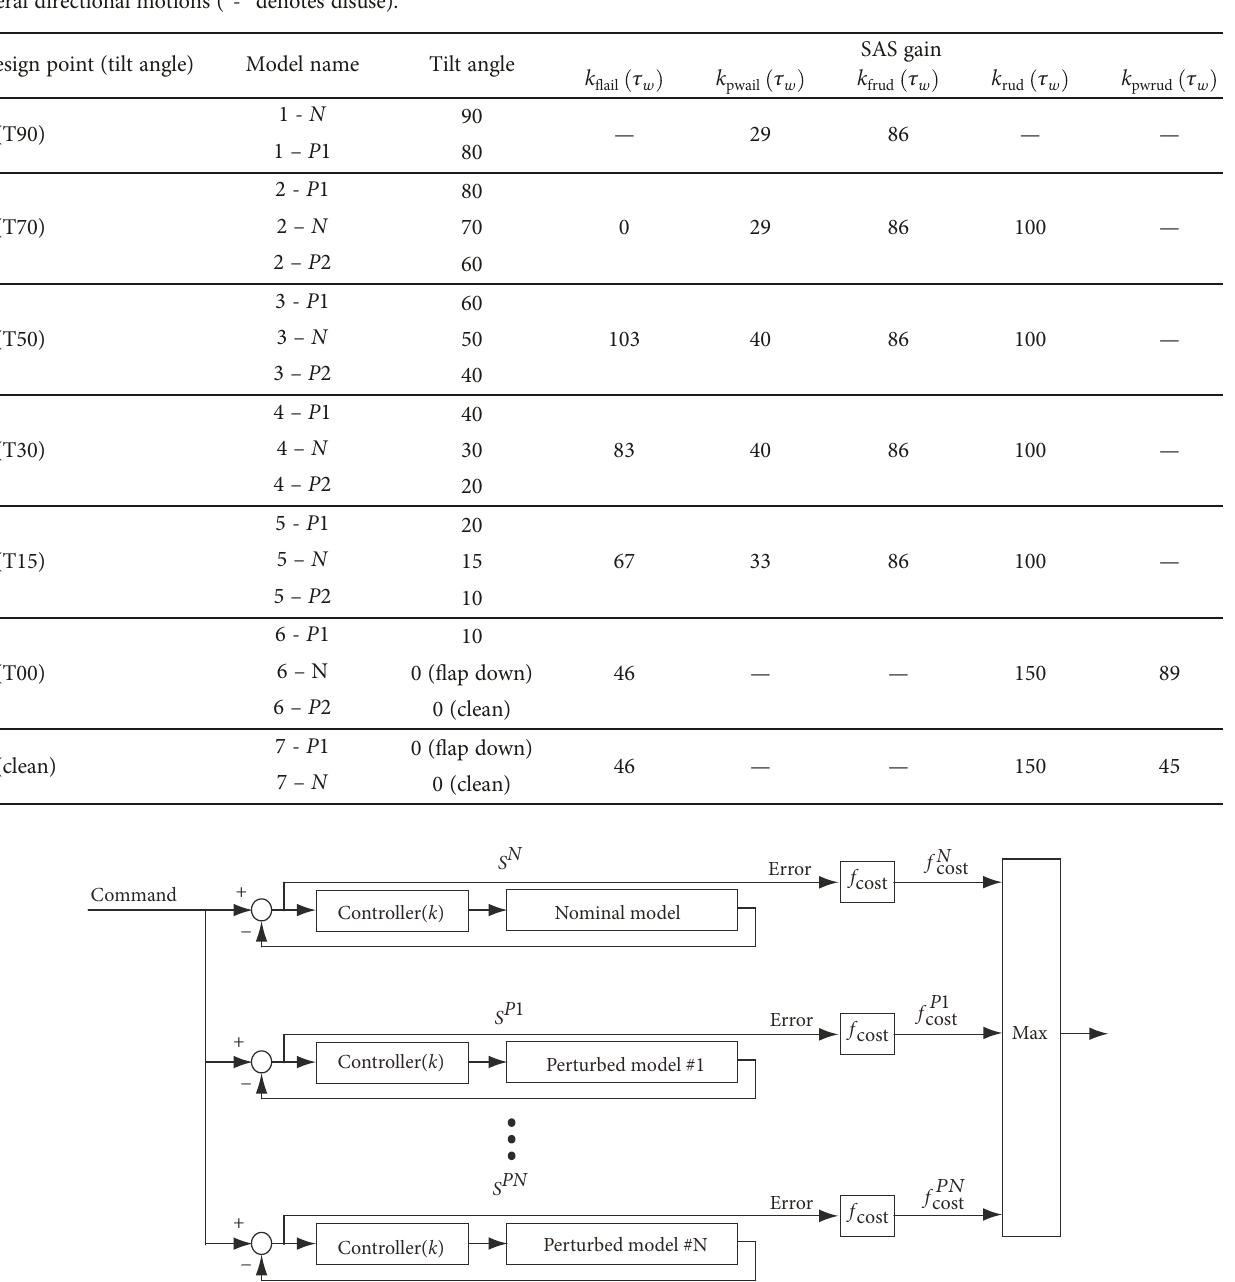
Figure 4: Concept of the multiple-model approach for designing robust controller gain k